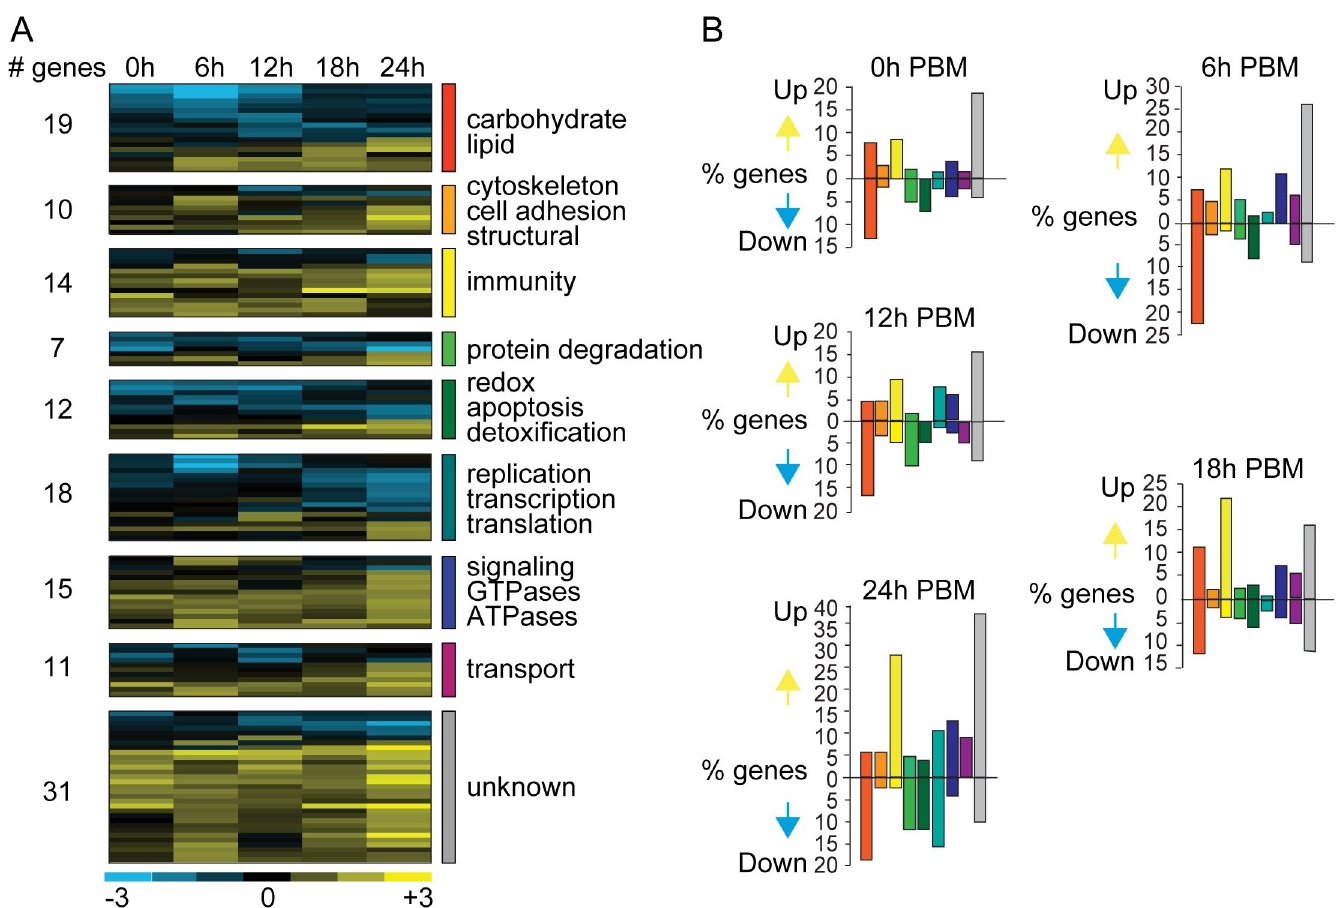
Fig 3. Gene transcription profiles upon blood feeding of SCD1 KD mosquitoes. ( A ) Heat map showing the transcription profiles of a total of 137 genes exhibiting at least 2-fold differential expression in SCD1 KD vs. dsLacZ -injected control across all time points. The time points examined are 0h (just prior to blood meal), 6h, 12h, 18h and 24h post bloodmeal (PBM). Blue color indicates downregulation and yellow color indicates upregulation, as shown in the color bar below the heat map. The data shown is the mean from 3 independent experiments. The number of genes grouped into each of 8 functional categories or are of unknown function is shown. ( B ) The graphs show the percentage of genes that are upregulated or downregulated in each time point and belonging to each of the 8 functional categories or having unknown function (grey colored bars). The color code of bars representing each of the functional categories is the same as the color code shown in panel A.